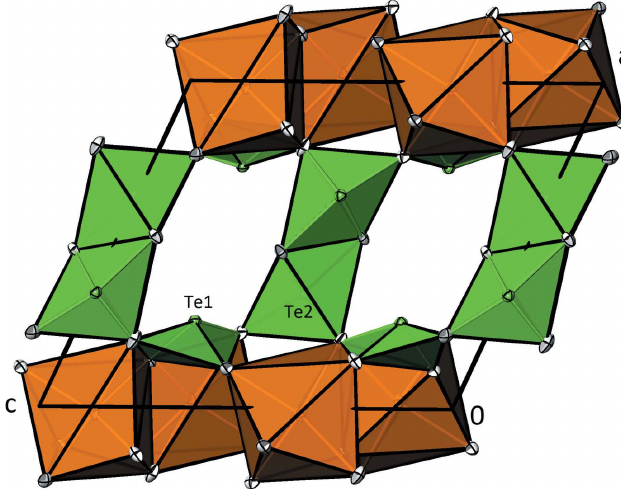
Figure 4 Large channels in the (cid:2) -CdTe 2 O 5 structure running parallel to [011]. Displacement ellipsoids are drawn at the 90% probability level.